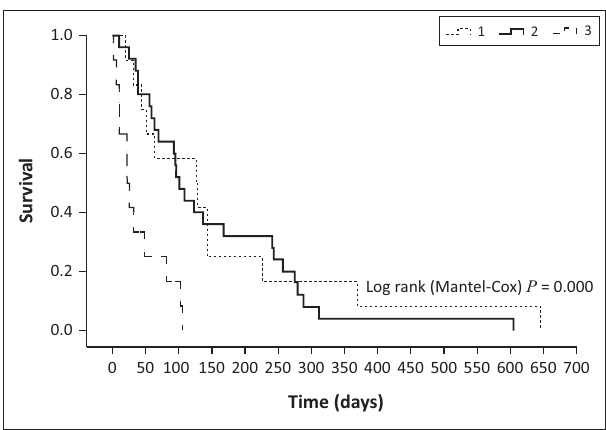
FIGURE 1: Kaplan-Meier curves of the study population survival by RTOG Recursive Partitioning Analysis score.